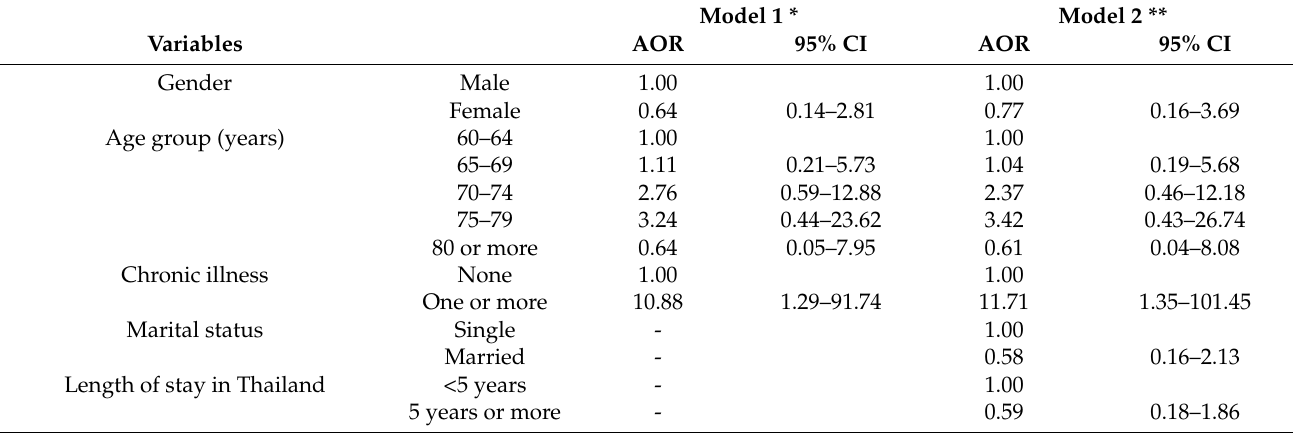
Table 3. Adjusted odds ratio (AOR) and 95% confidence interval (CI) of logistic regression analysis for possible neurosis †